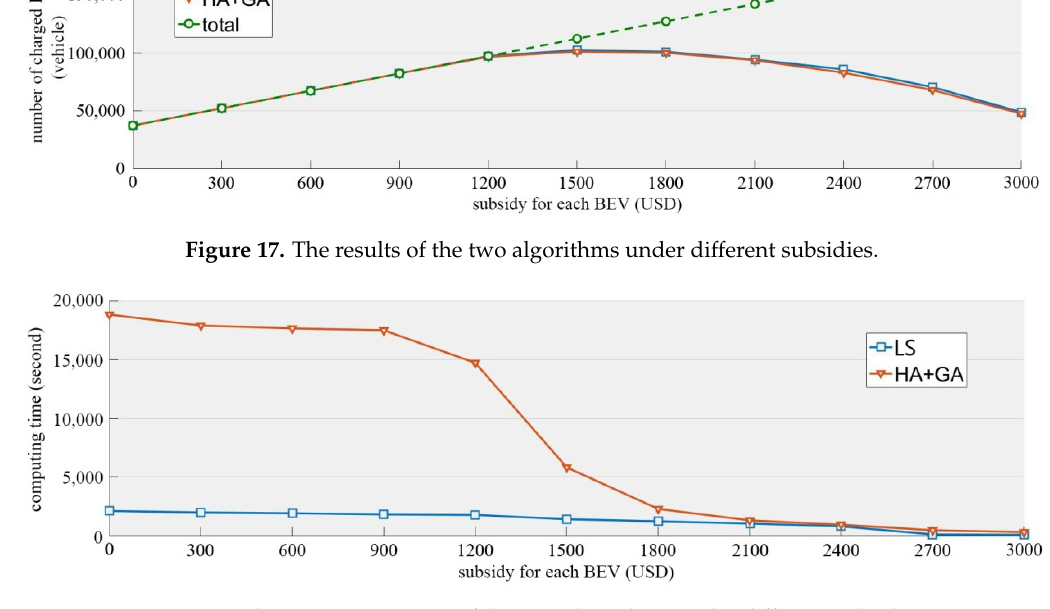
Figure 18. The computing times of the two algorithms under different subsidies.